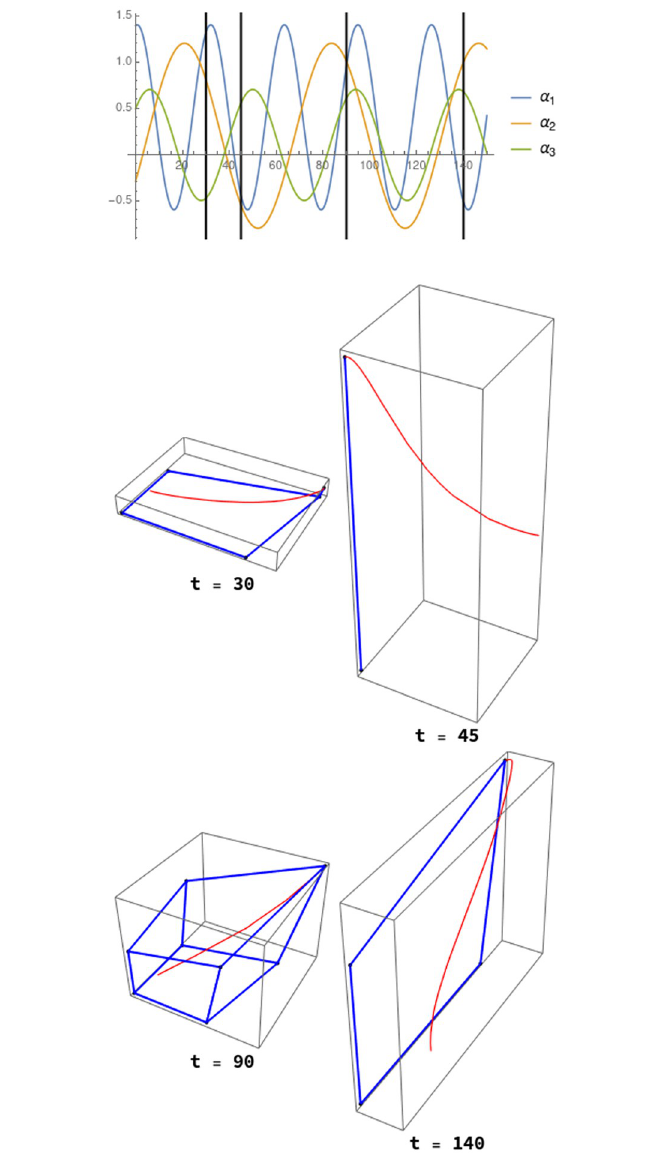
Fig 2. The evolution of four different scenarios defined over the same graph in the same state. A three-nodes graph is considered. A system of differential equations as (2) is defined for the three nodes. Here, γ Below, the evolution in time (red lines) from the state (0.2, 0.2, 0.2) of the system, depending on the value of the α i parameters which affect the behaviour of the nodes of the graph but not to its connectivity. The starting point of the red trajectories is always the same initial point but the trajectories are quite different. The changes in the trajectories are governed by the different information structures (figures delimited by the blue lines) in each of the dynamical systems which determine the future scenarios of the system. In each case, the trajectory goes to a special point which is the global stable solution in the phase space.